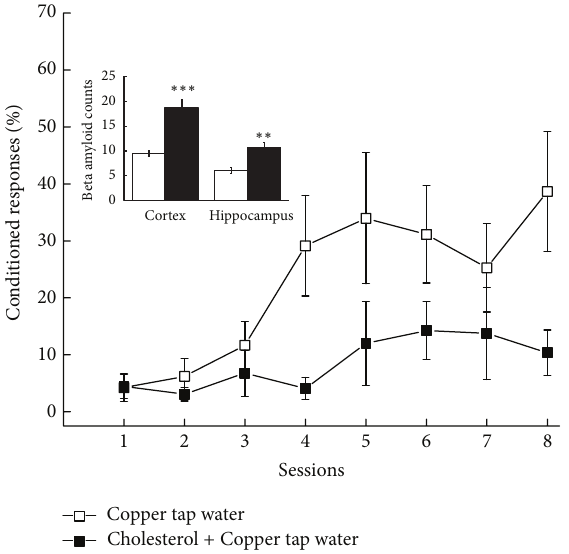
Figure 3: Mean percent ( ± SEM) conditioned responses to a tone conditioned stimulus as a function of eight days of pairings (Ses- sions) of the tone and air puff to the eye for rabbits fed normal rabbit chow and given 0.12 parts per million copper as copper sulfate in their tap water (Copper Tap Water) or fed 2% cholesterol and given 0.12 parts per million copper in their tap water (Cholesterol + Copper Tap Water). The inset shows the mean ( ± SEM) number of counts of beta amyloid immunoreactive cells in the cortex and hip- pocampus. The data show lower levels of trace conditioning of the nictitatingmembraneresponseandnumberofbetaamyloidpositive cells in rabbits fed cholesterol and given copper in their tap